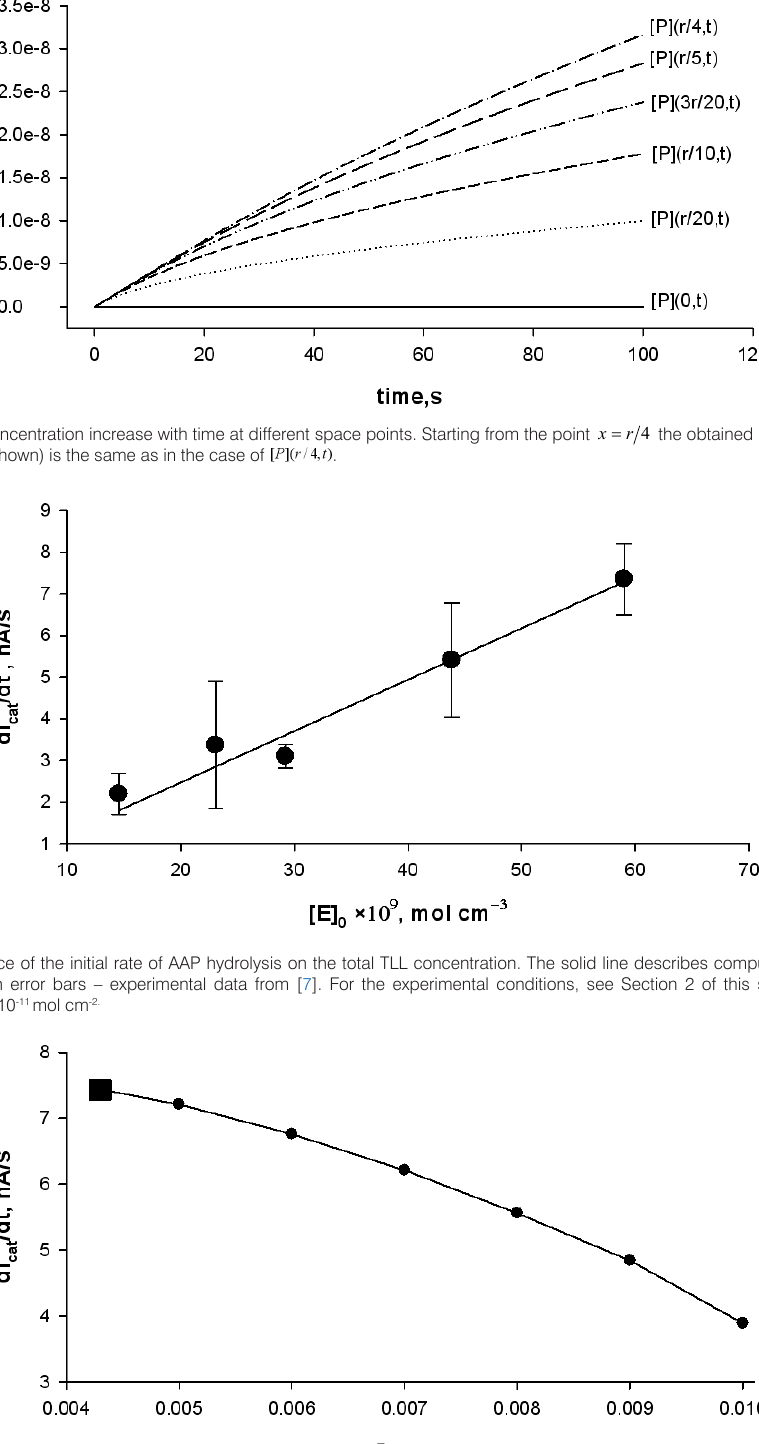
. dl =5.9×10 -8 mol cm -3 0